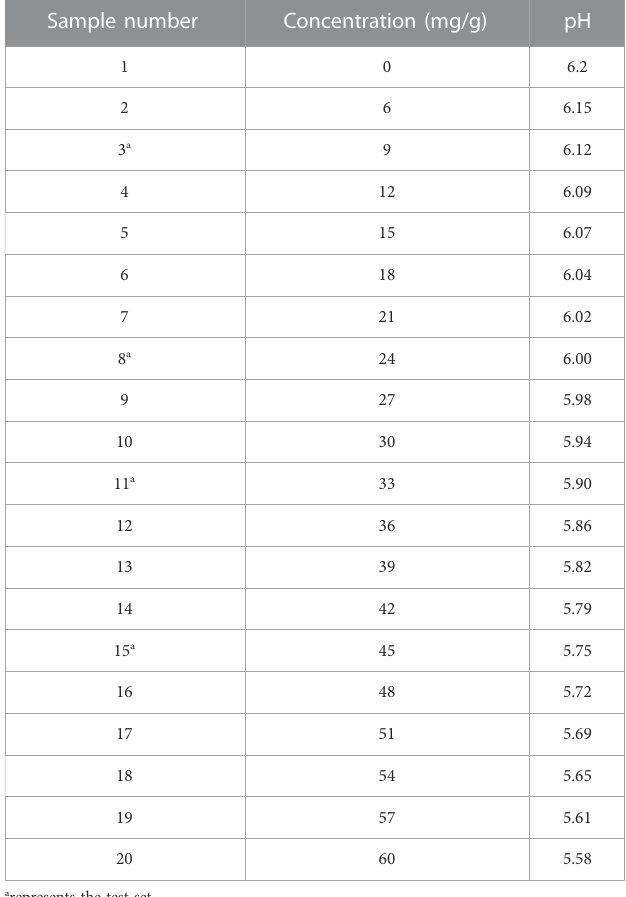
TABLE 1 Concentration of FeSO 4